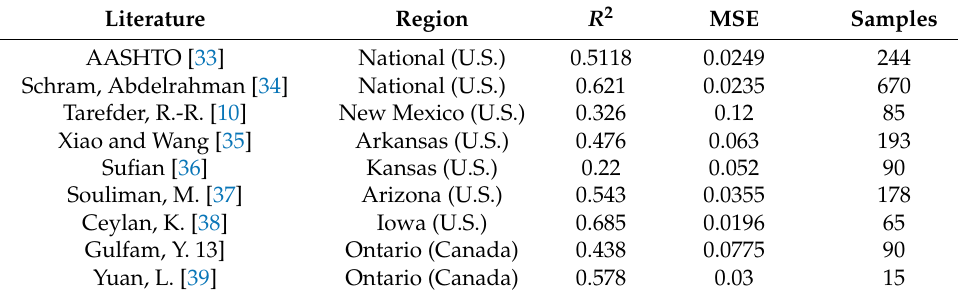
Table 1. A summary of efforts in calibrating IRI